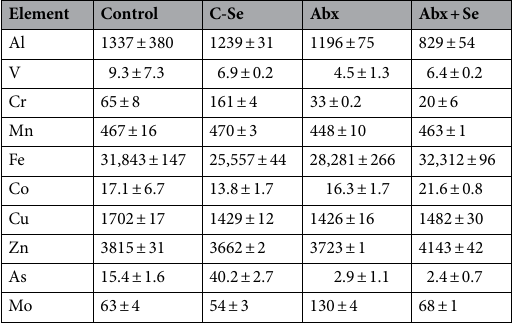
Table 1. Concentration of elements (ng g −1 ) expressed as mean ± SD (n = 3) in mice testicles from the different